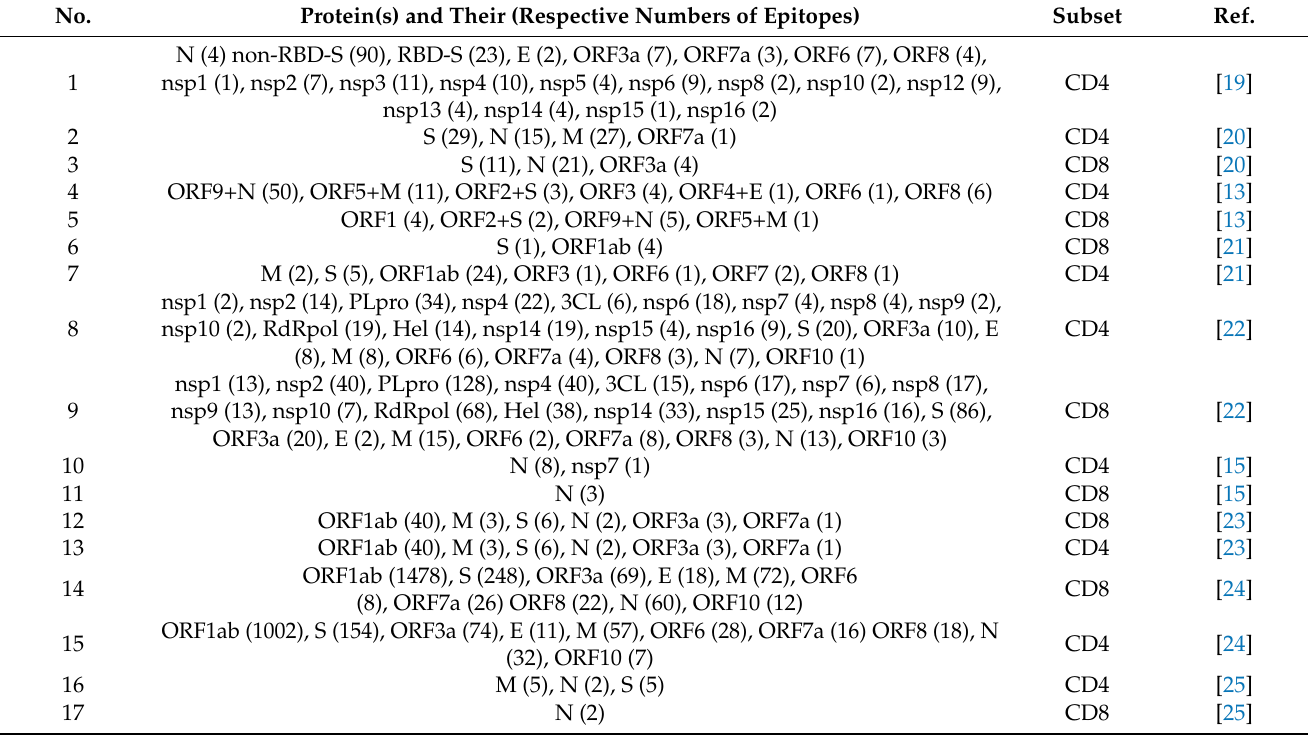
Table 1. Distribution of CD4+ and CD8+ epitopes based on SARS-CoV-2 proteins.